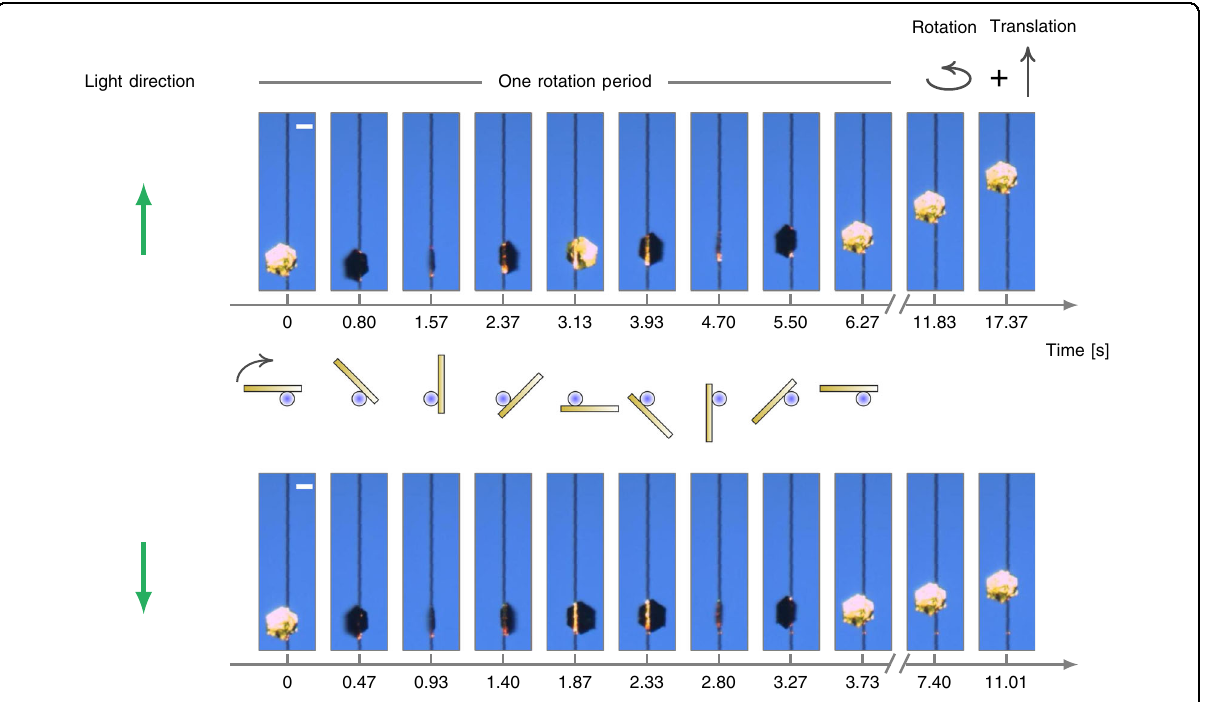
Fig. 3 Sequential optical images of a hexagonal gold plates moving around micro- fi bers spirally in ambient conditions, showing that both rotation and translation directions are independent of incident light directions. All scale bars represent 15 µm. The laser source has the same parameters as in Fig.